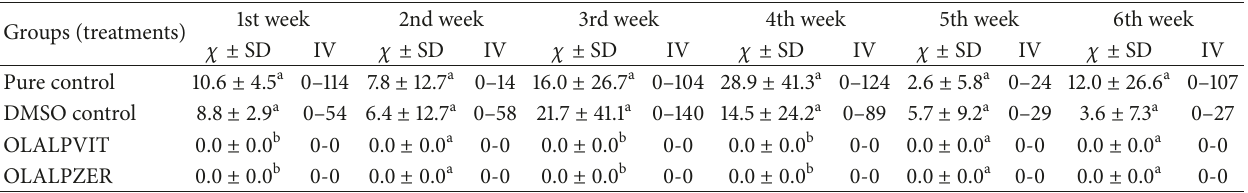
Table 2: Mass difference (mg) before and after feeding observed in R. nasutus treated with OLALPVIT and OLALPZER at 125 𝜇 g/ 𝜇 L under laboratory conditions.